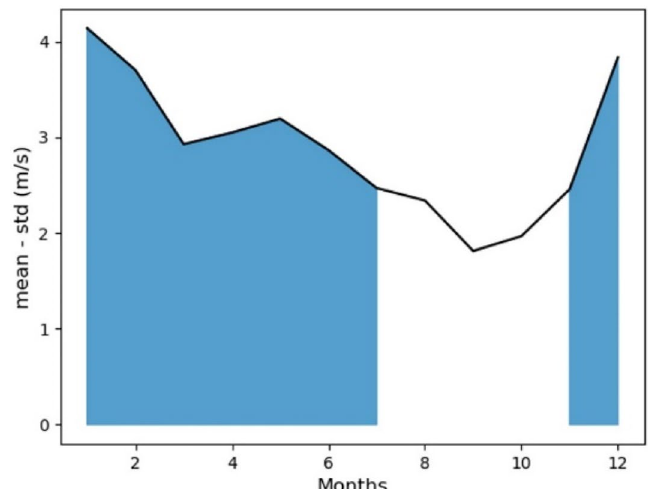
Fig. 19 Optimal production period determination